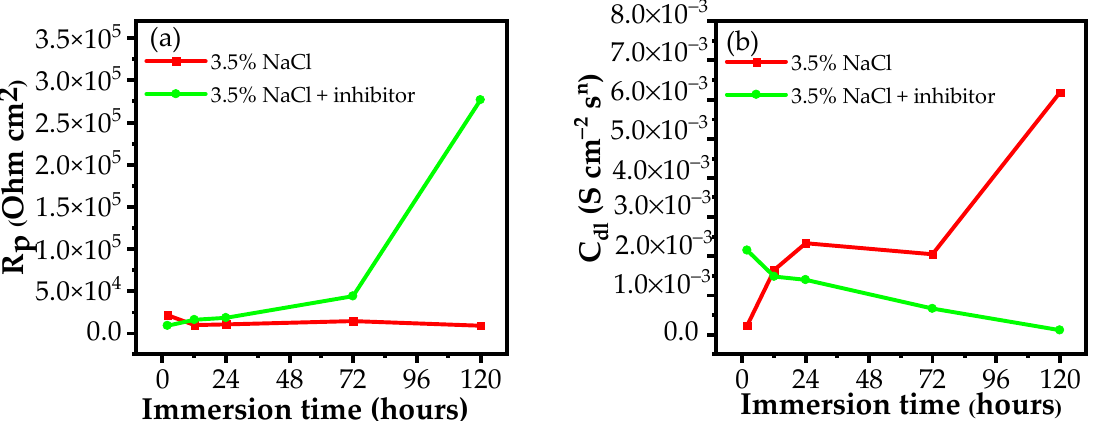
Figure 6. ( a ) The R p values, and ( b ) the C dl values of AA2024-T3 in 3.5% NaCl in the absence and presence of a corrosion inhibitor versus immersion time derived from the EIS curves.